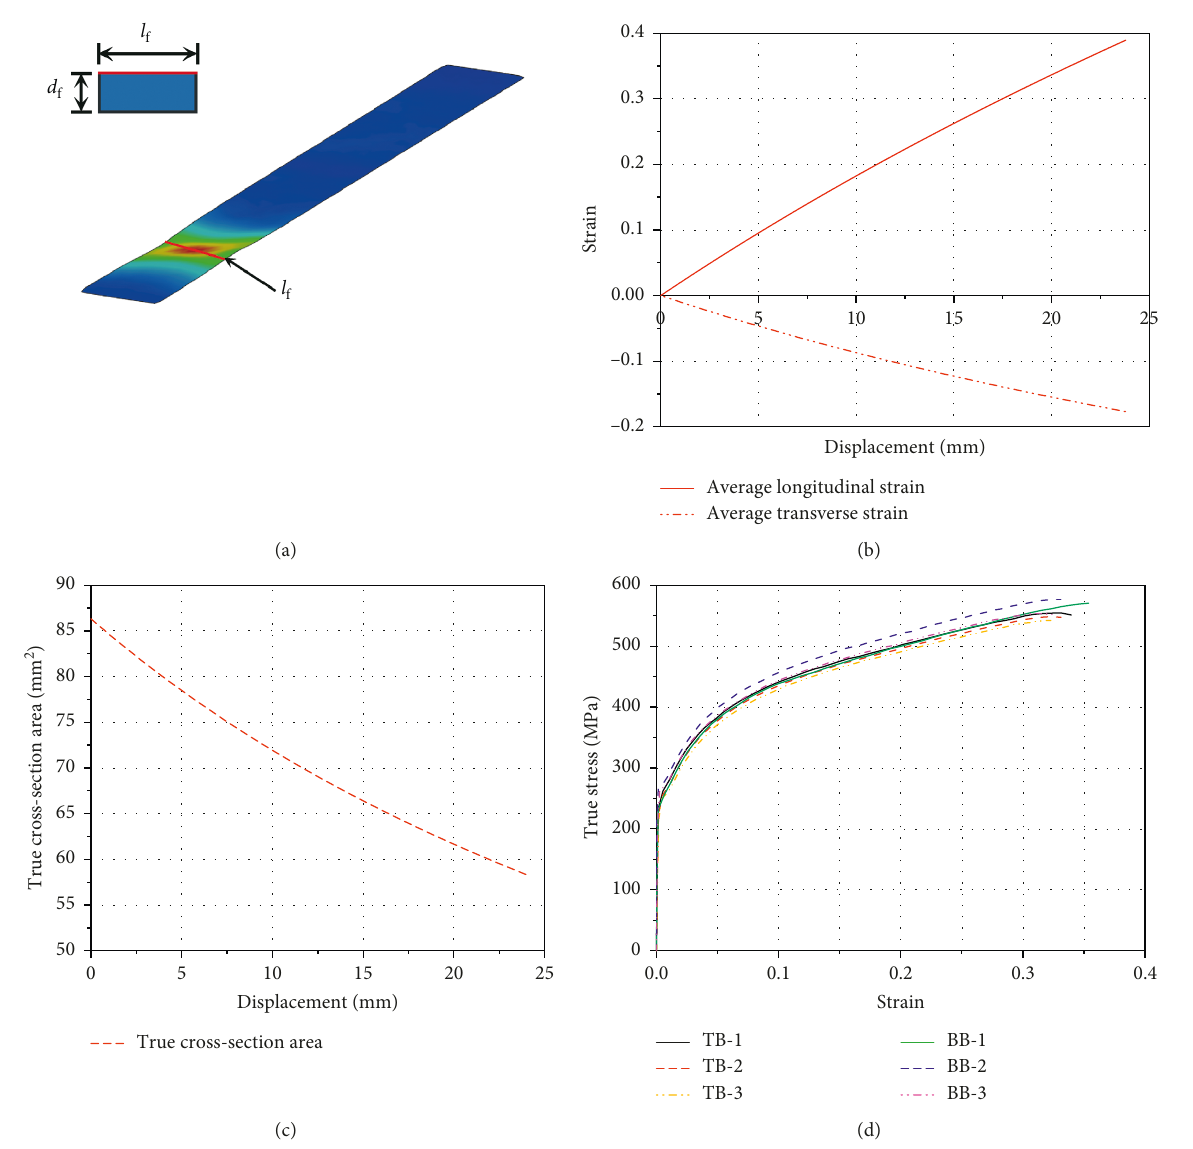
Figure 10: Capture of true stress-strain curves of flat coupon: (a) diagram of real-time section area capture of flat coupon; (b) average strain; (c) true cross-section area; (d) true stress-strain curves of flat